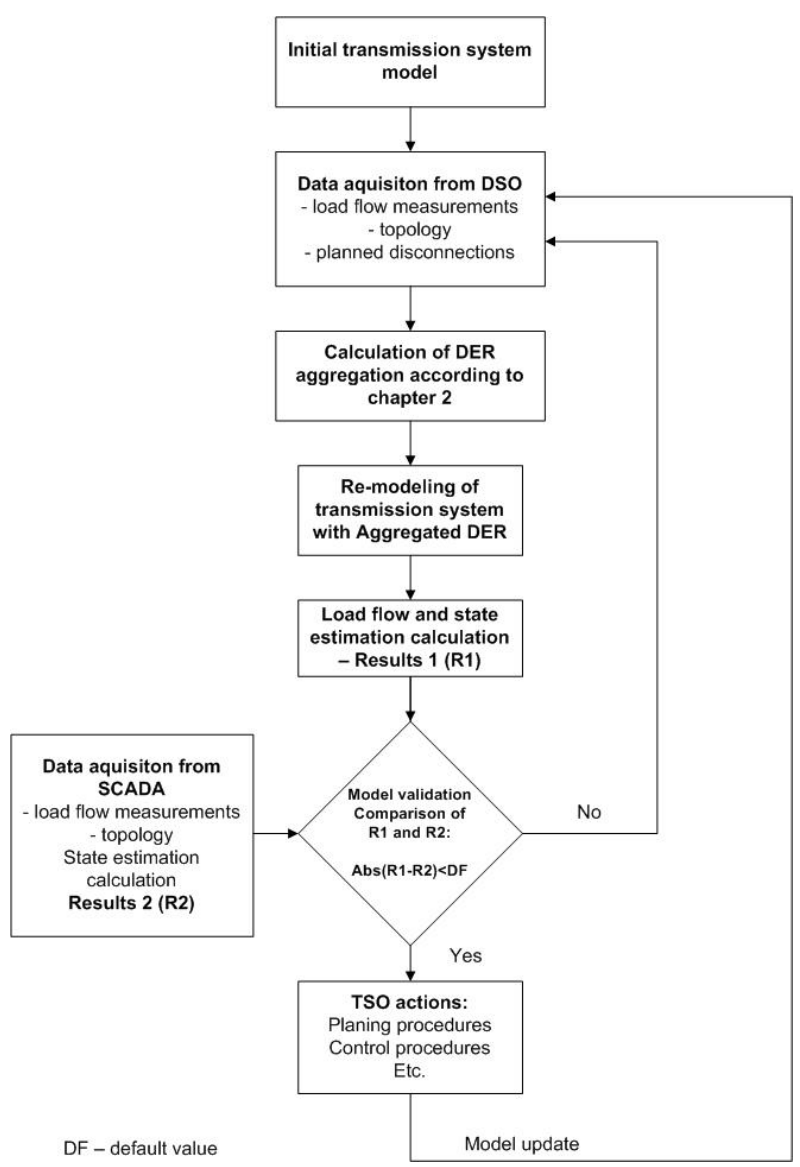
Figure 3. Algorithm for power transmission system modelling based on TSO-DSO data exchange.